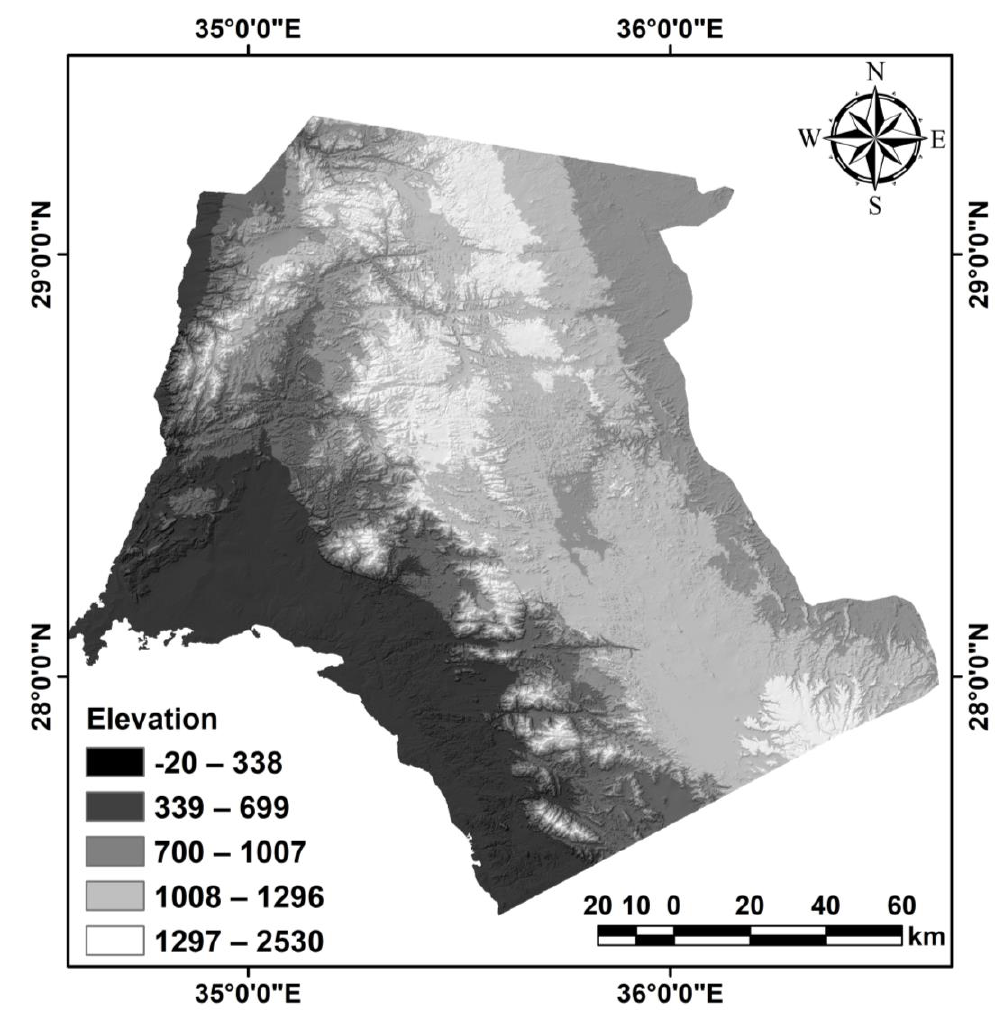
Figure 3. Digital elevation model of the surface elevation in Neom, with a flat coastal plain ranging from −20 to 338 m AMSL in the west and the mountains in t he central area rising to 2530 m AMSL.